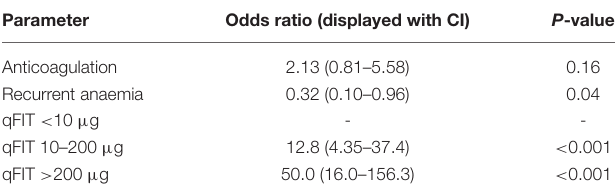
TABLE 4 | Multivariate logistic regression